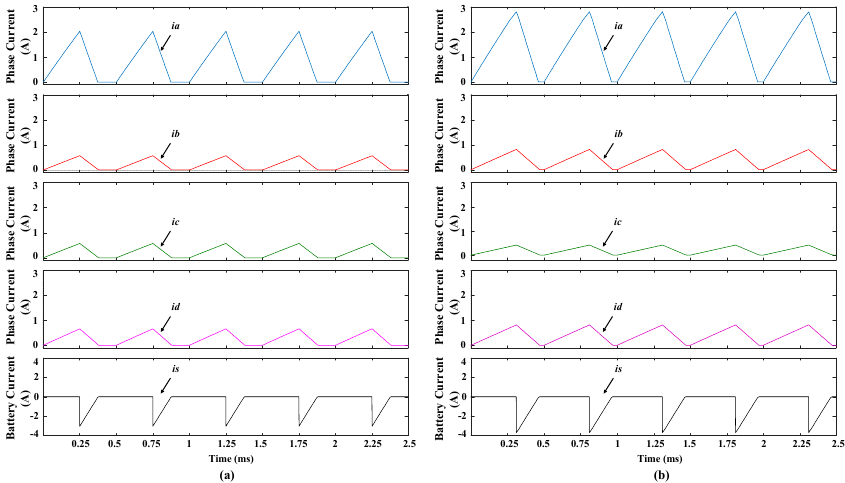
Figure 16. Simulation waveforms of battery charging performance: ( a ) duty cycle: 50% and ( b ) duty cycle: 60%.